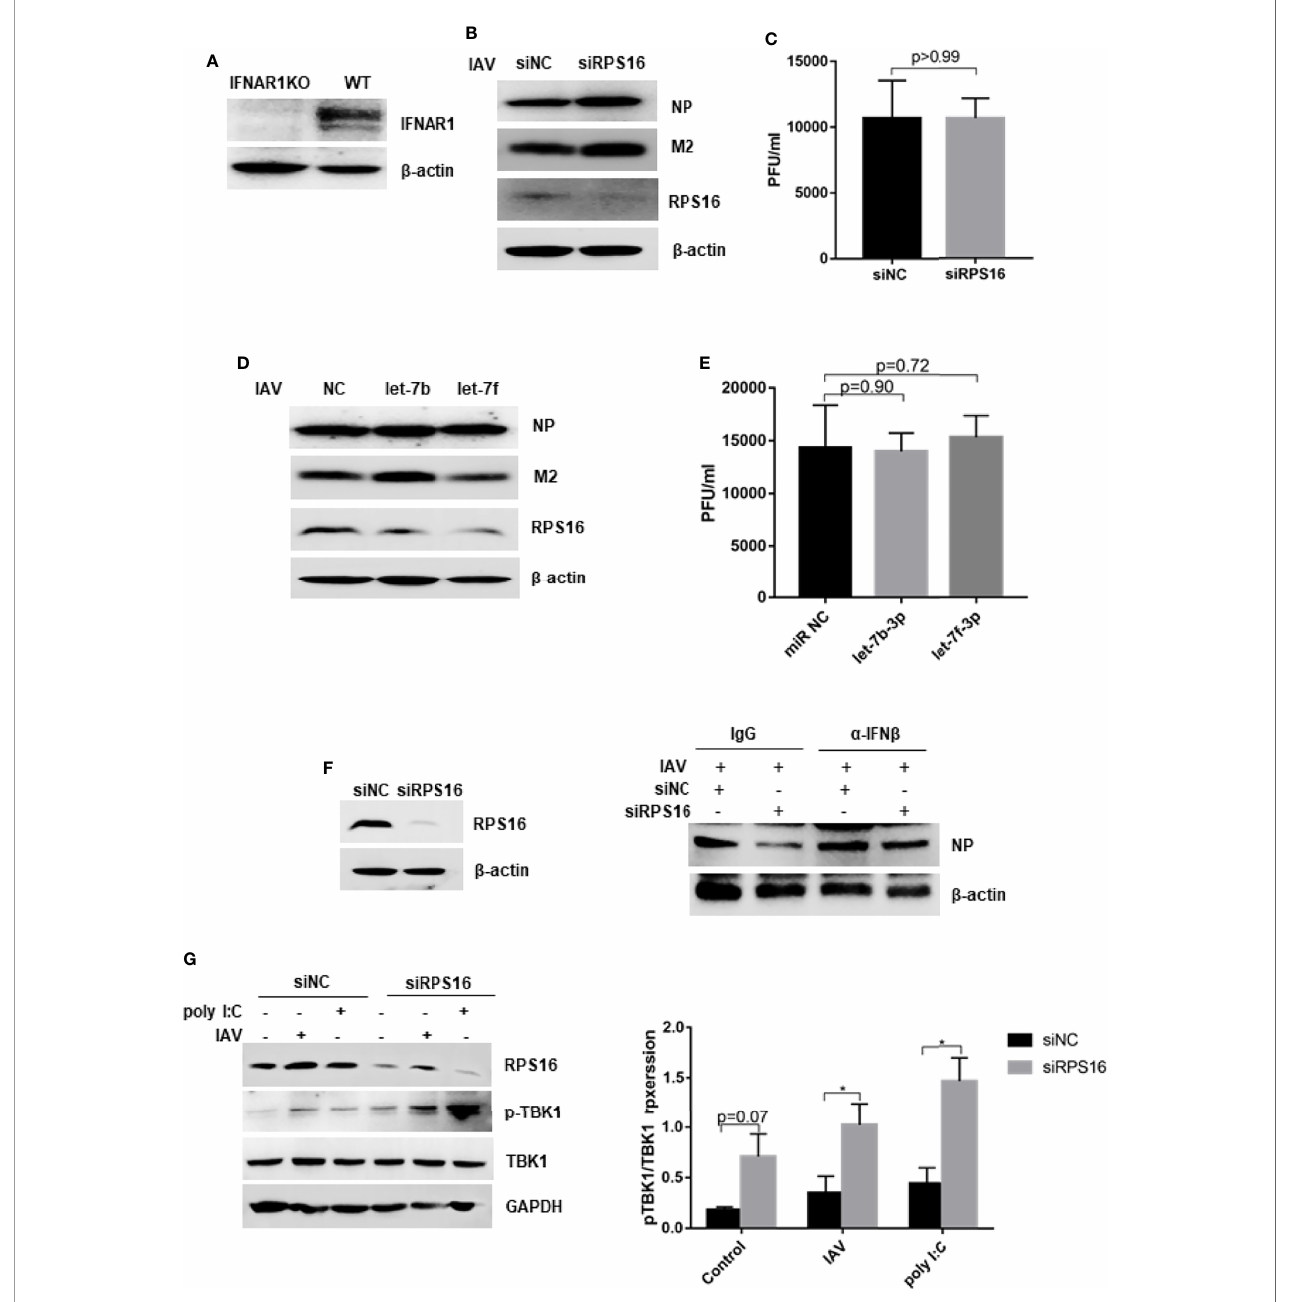
FIGURE 7 | Dampening type I IFN signaling impairs inhibition of IAV replication by let-7 and siRPS16. (A) The expression of IFNAR1 was tested by western blot in IFNAR knock out (KO) and wild type A549 cell. The IFNAR1-/- A549 cell was transfected with 50nM mimics of hsa-let-7b-3p, hsa-7f-3p or negative control (miR NC); (B) at 48 h post transfection, the cells were infected with in fl uenza A/WSN/1933 virus (MOI = 0.1), the expression of in fl uenza NP and M2 protein were detected by western blot; (C) the new born virus titer in the supernatants was tested by plaque forming assay. IFNAR1-/- A549 cell was transfected with siRPS16 or siNC (50nM); at 48h post transfection, the cells were infected with in fl uenza A/WSN/1933 virus (MOI = 0.1), (D) the expression of in fl uenza NP and M2 protein were detected by western blot; (E) the new born virus titer in the supernatants was tested by plaque forming assay; (F) wild-type A549 cell was transfected with siRPS16 (or siNC control), the transfected cell was infected with in fl uenza A/WSN/1933 virus (MOI = 0.1) at 48h post transfection; the cell was maintained with the medium including IFN- b or isotype control IgG. Viral NP expression was detected by western blot at 24 post infection. (G) Wild-type A549 cell was transfected with siRPS16 or siNC. At 48h post infection, the cell was infected with 3 MOI of in fl uenza A/WSN/1933 virus or transfected with 1µg/ml poly I:C for 12h, the expression of TBK1 was detected by western blot. The gray scale of pTBK1 was analyzed by Image J normalized to the gray scale intensity of TBK1. Data are the representative of three independent